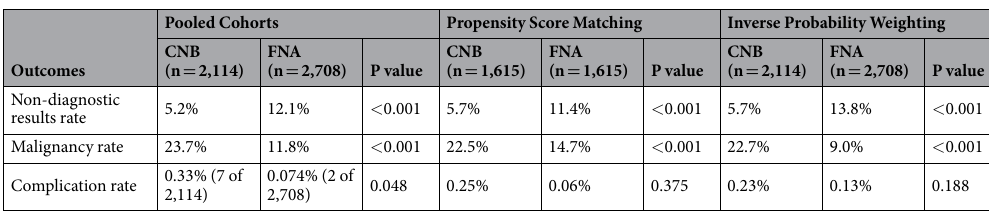
Table 3. Outcomes of the Pooled and Matched